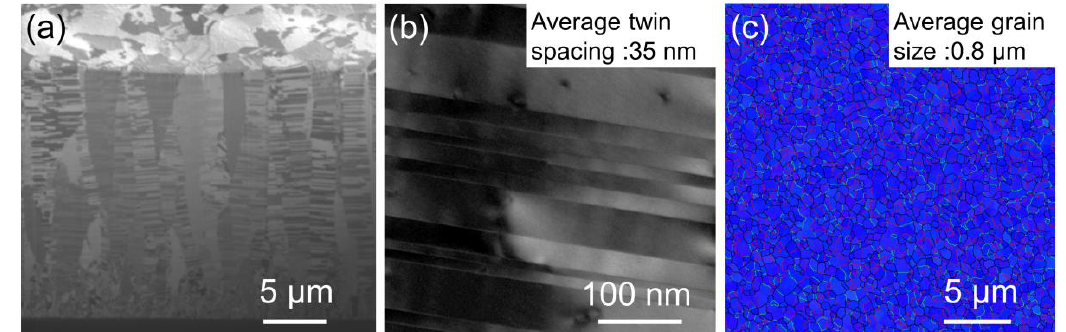
Figure 3. Microstructure of the copper foils. These figures show ( a ) the cross-sectional ion images; ( b ) TEM image, average twin spacing of 35 nm; ( c ) plane view EBSD of <111>-oriented nt-Cu foil, average grain size of 0.8 μm. Low-angle grain boundary, high-angle grain boundary, and twin boundary are marked in green lines, black lines, and red lines, respectively.